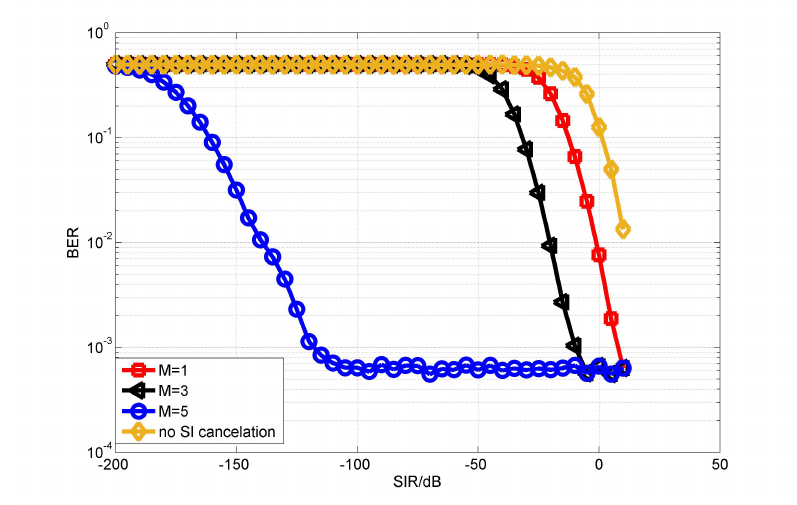
Figure 6. BER performance of OPRLS without quantization